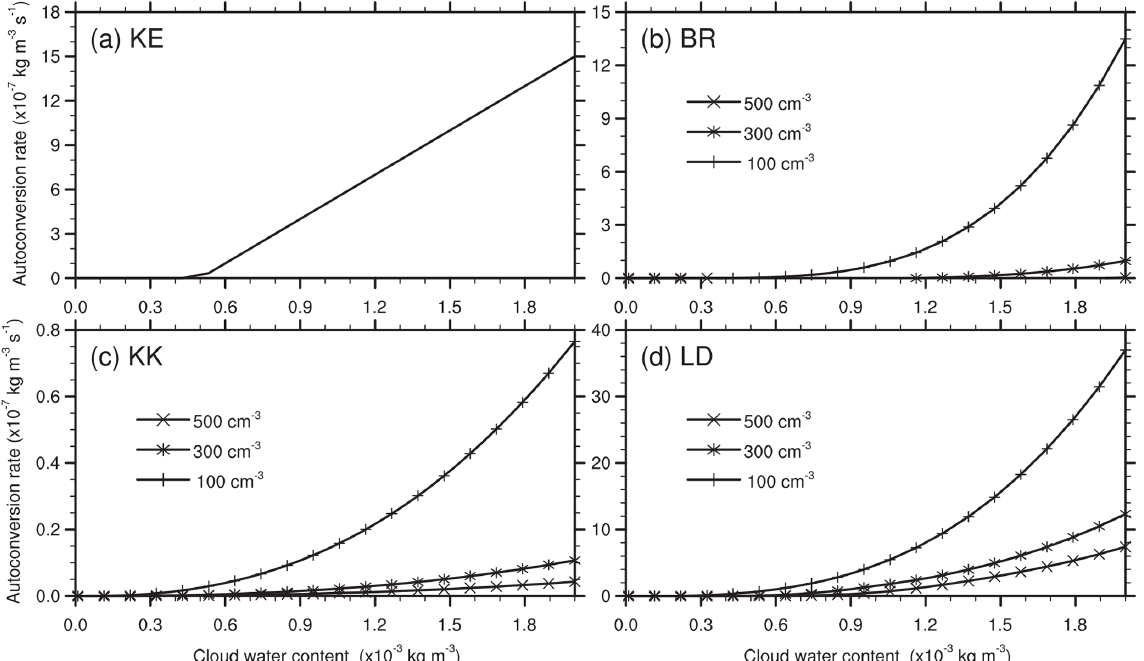
Figure 1. Evolution of autoconversion rates with a wide range of cloud water content at given cloud number concentrations ( N c ) of 100, 300, and 500cm − 3 , respectively. (a) KE denotes the Kessler scheme (1969), and (b) BR indicates the Berry and Reinhardt scheme (1974); (c) KK and (d) LD represent the Khairoutdinov and Kogan (2000) and Liu et al. (LD) schemes (2006),